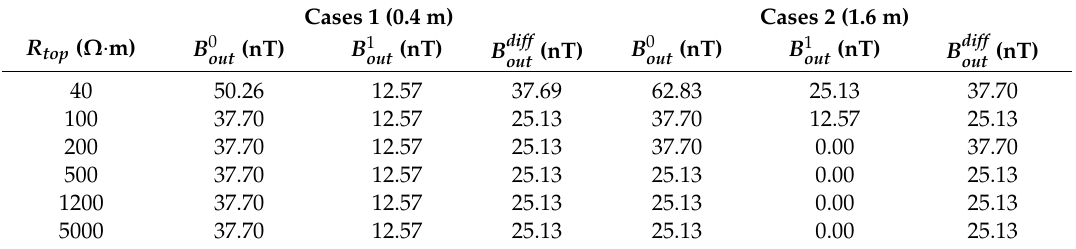
Table 2. The induced secondary magnetic field intensity B out ( nT ) measured on the surface at point ( 60 m, 65 m )